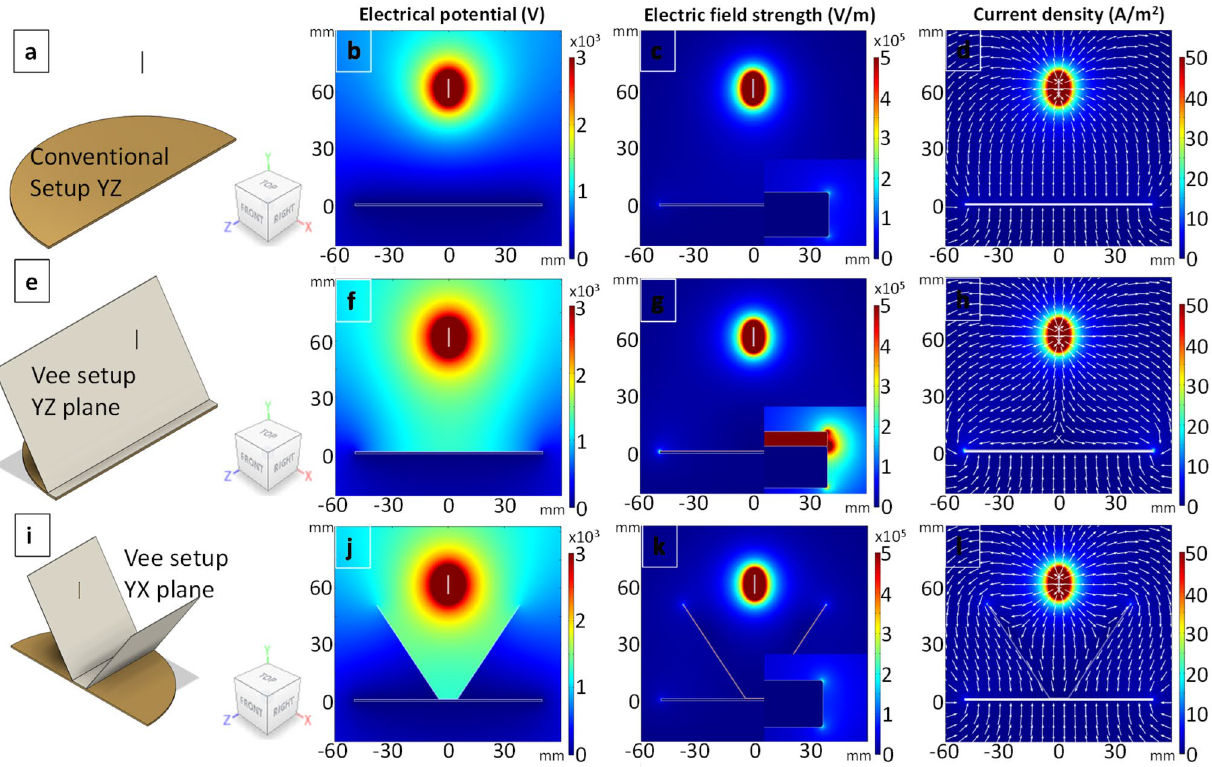
Figure 4. ( a – l ) The view planes for the conventional electro-spinning setup, the YZ and YX planes for the Vee- shield method are shown in ( a ), ( e ) and ( i ) respectively. The electrical potential, electric field strength and the current density are shown in the second, third and fourth columns respectively. The inserts in ( c , g and k ) show a magnified view of the extreme edge of collector and the electric field